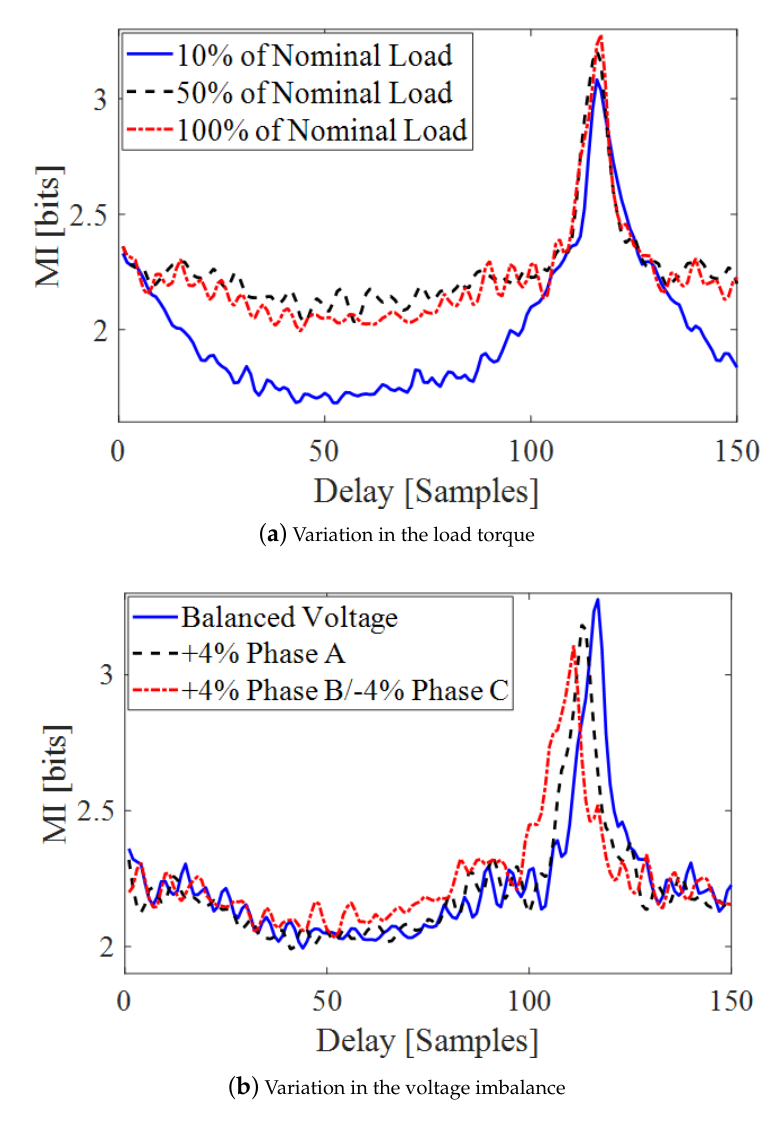
Figure 7. Analyzes of variations in the load torque and voltage imbalance levels—Motor 1 operating with broken rotor